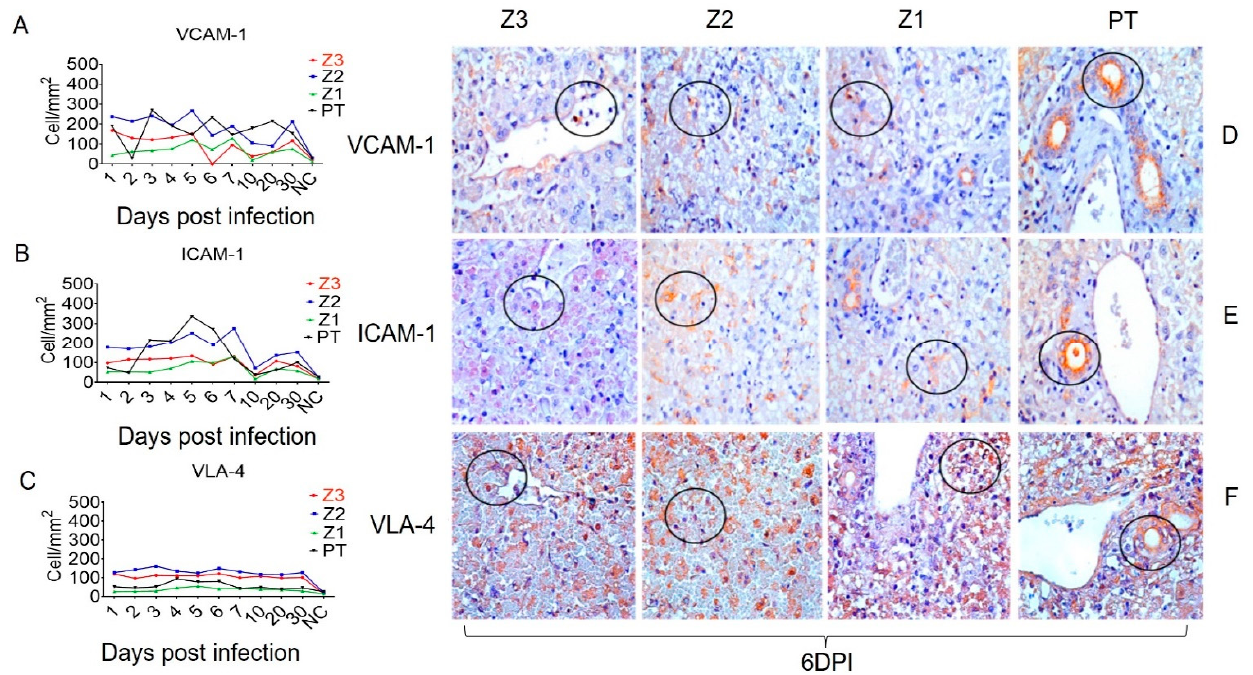
Figure 3. Quantitative immunohistochemical analysis of selected endothelial cell markers in zones Z3, Z2, Z1 and PT in hepatic parenchyma of squirrel monkeys ( Saimiri spp.) infected with YFV. Circles represent areas expressing higher immunostaining cells in different hepatic areas. ( A ) Expression of VCAM-1. ( D ) Immunostaining for VCAM-1 in the inflammatory infiltrate (D-Z3), in Kupffer cells (D-Z2), (D-Z1) and bile duct (D-PT). ( B ) Expression of ICAM-1. ( E ) Immunostaining for ICAM-1 in hepatocytes (E-Z3), (E-Z2), (E-Z1) in Kupffer cells, (E-PT) in the bile duct. ( C ) VLA-4 expression. ( F ) Immunostaining for VLA-4 in endothelial and Kupffer (F-Z3) cells, (F-Z2) in inflammatory infiltrate, (F-Z1), (F-PT) in 6dpi bile duct.